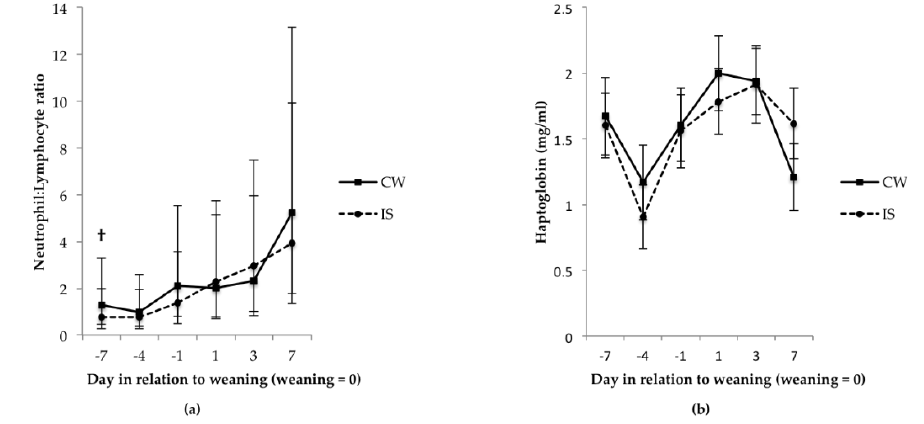
Figure 2. Effects of IS on plasma ( a ) N:L ratio and ( b ) haptoglobin of piglets before and after weaning. † Indicates trends between treatments ( p < 0.1) per sampling day; n = 20 for CW and n = 22 for IS. Data for N:L ratios were were logarithmically transformed and then back transformed and expressed as least square means with 95% confidence intervals.